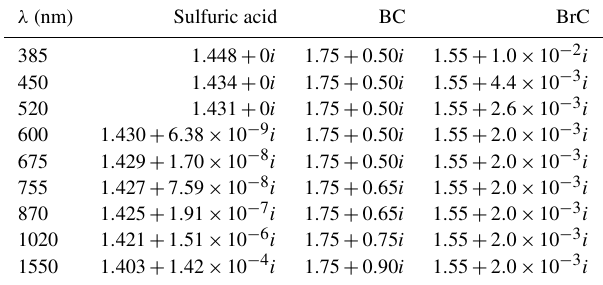
Table 1. Complex refractive indices for smoke and sulfuric acid used in the Mie simulations. The smoke refractive index values were based on data collected by Bergstrom et al. (2002) for BC and Sum- lin et al. (2018) for BrC. Sulfuric acid refractive index values are from Palmer and Williams (1975).